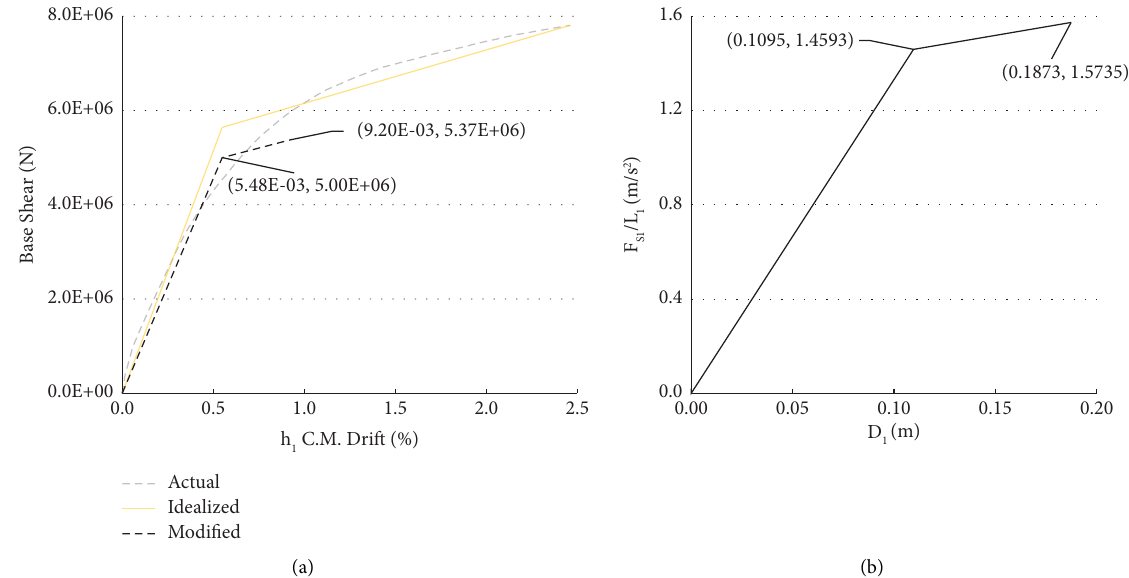
Figure 11: Modifed force-displacement curve: (a) modifed base shear-reference point displacement curve and (b) corresponding force- displacement